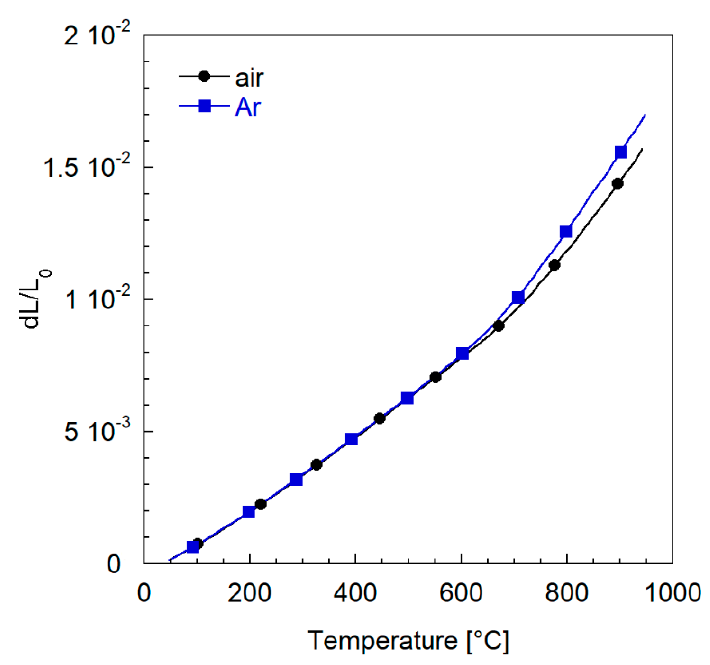
Figure 14. Expansion behavior of LSCF samples in air and Ar atmospheres, from heating curves. This behavior reflects in the calculated coefficients of thermal expansion (CTE), re- ported in Table 5, which shows a significant difference in the high temperature region. Table 5. CTE derived from heating curves in different atmospheres and temperature regions. Values are expressed in 10 − 6 K − 1 . A comparison with the literature for air atmosphere is also reported [28]. A tmosphere